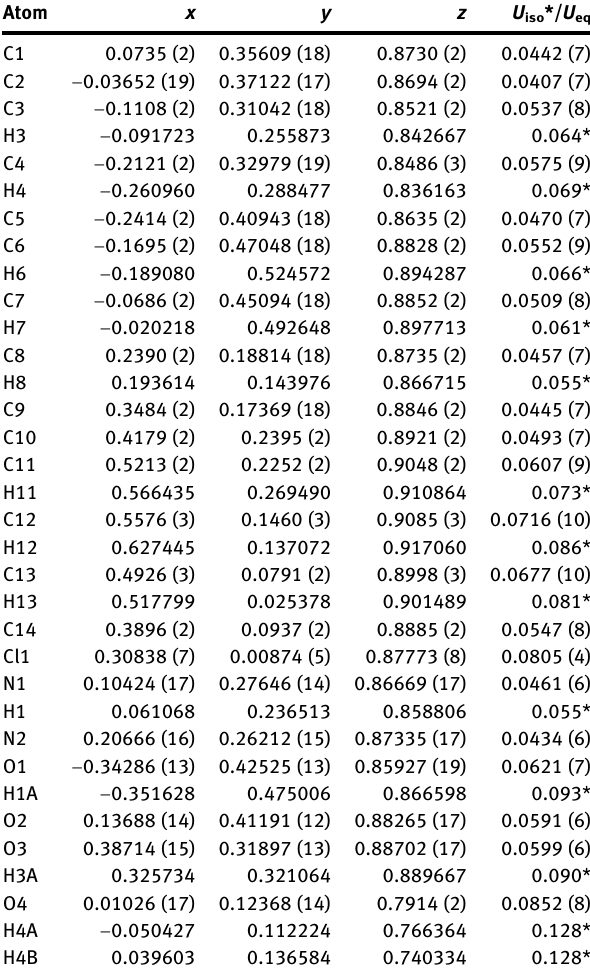
Table  : Fractional atomic coordinates and isotropic or equivalent isotropic displacement parameters (Å 